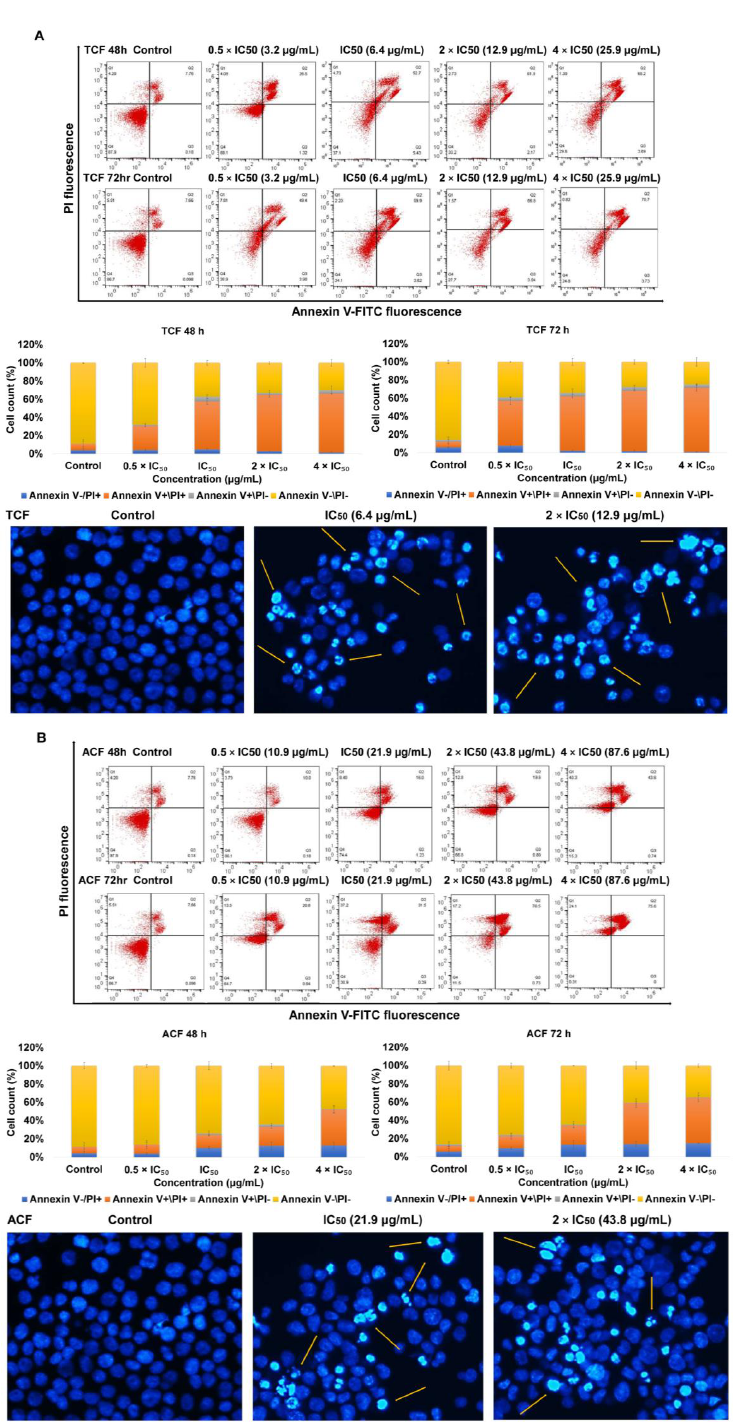
Figure 2. Apoptosis induction in NCI-H929 cell lines. Annexin V/PI assay of NCI-H929 cells incubated with 0.5, 1, 2, 4 × IC 50 of chloroform fractions of ( A )- T. vulgaris (TCF) and ( B )- A. lappa (ACF) for 48 and